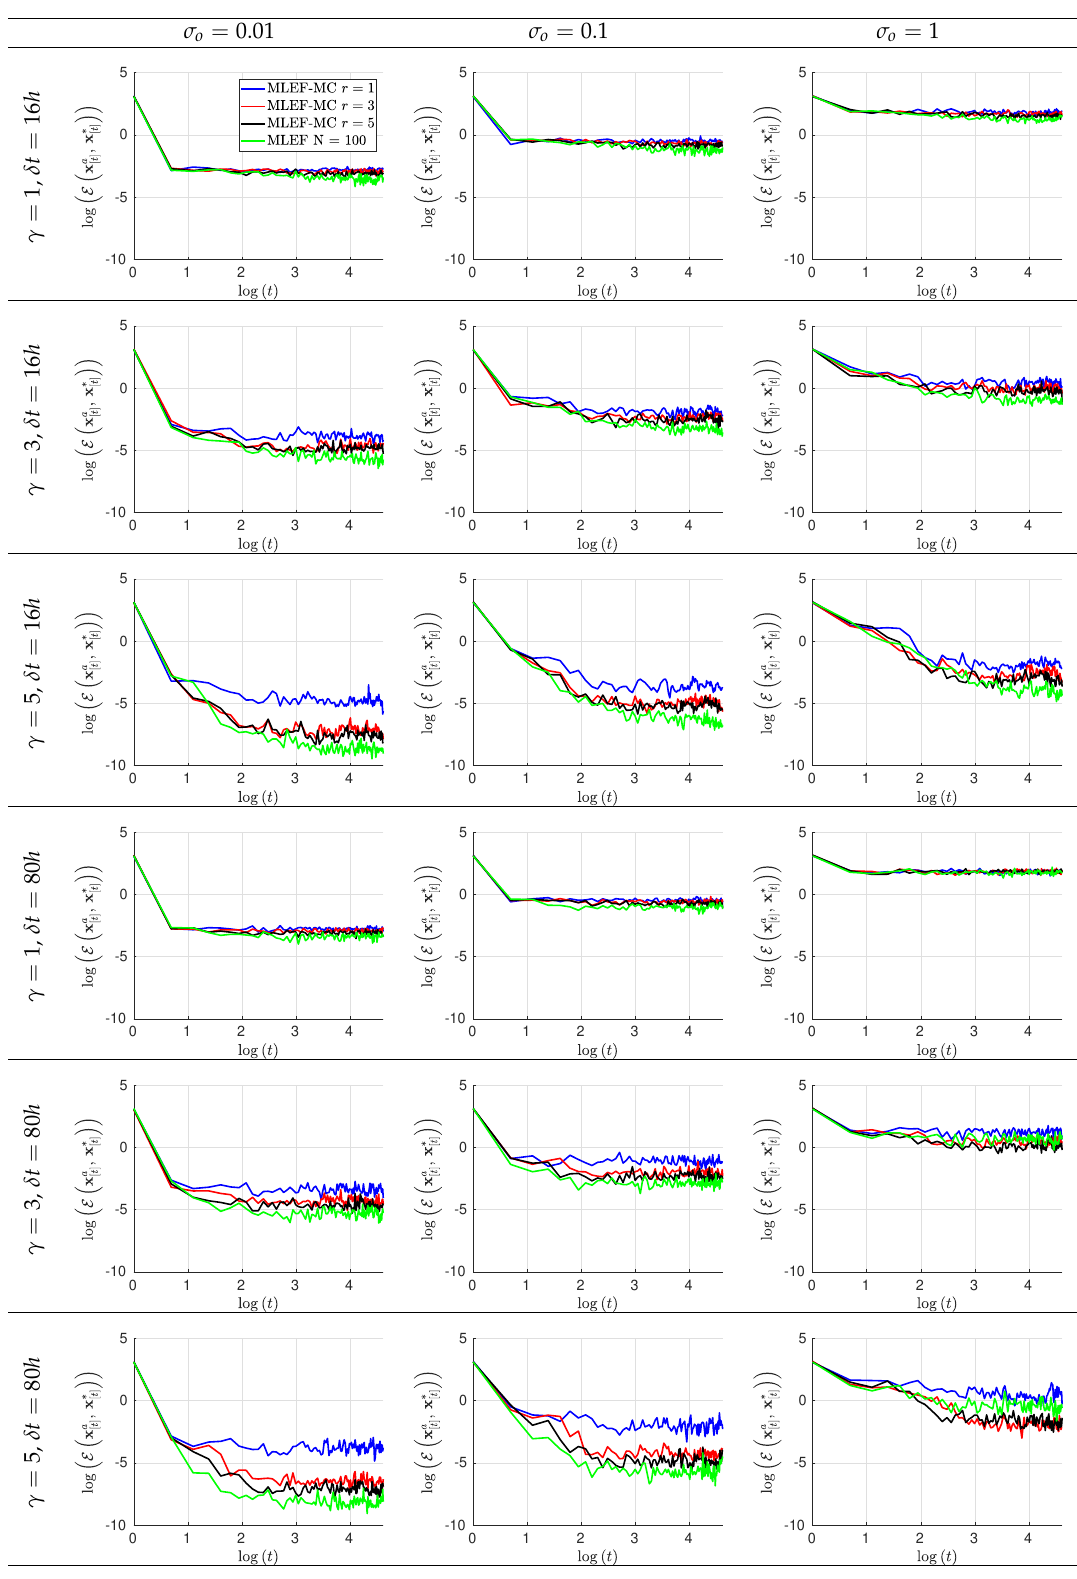
Figure 3. Error evolution in the log-scale of the compared filter implementations. Different time frequencies of observations were employed during the experiments. The percentage of observations from the model state reads s =